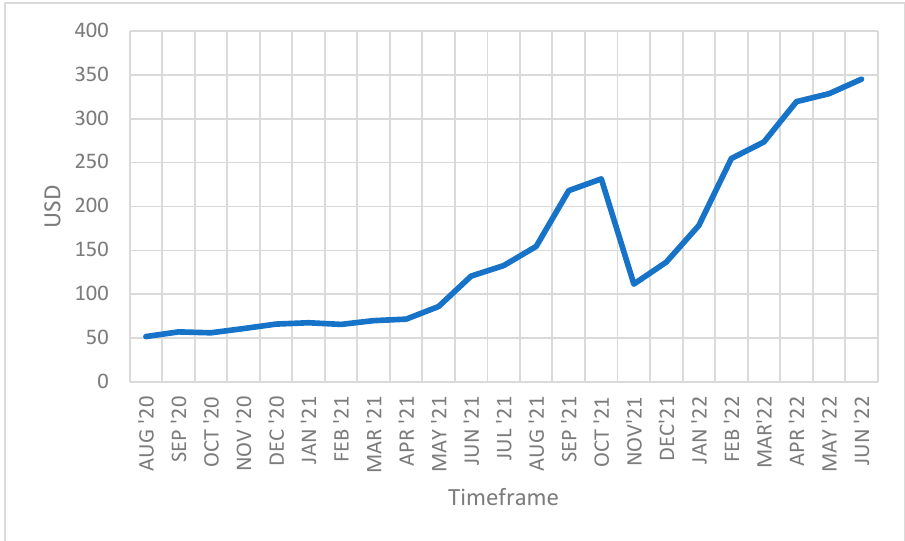
Figure 1. Timeframe for coal price—(API2) CIF ARA (ARGUS-McCloskey) Futures (MTFc1)—